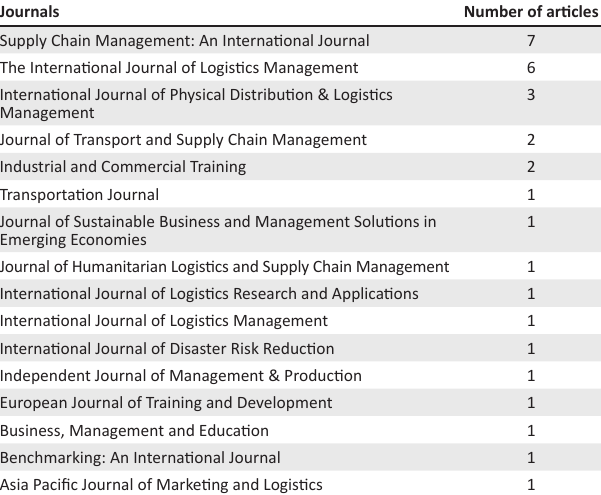
TABLE 4: Authors’ affiliation institutions. TABLE 5: Distribution of